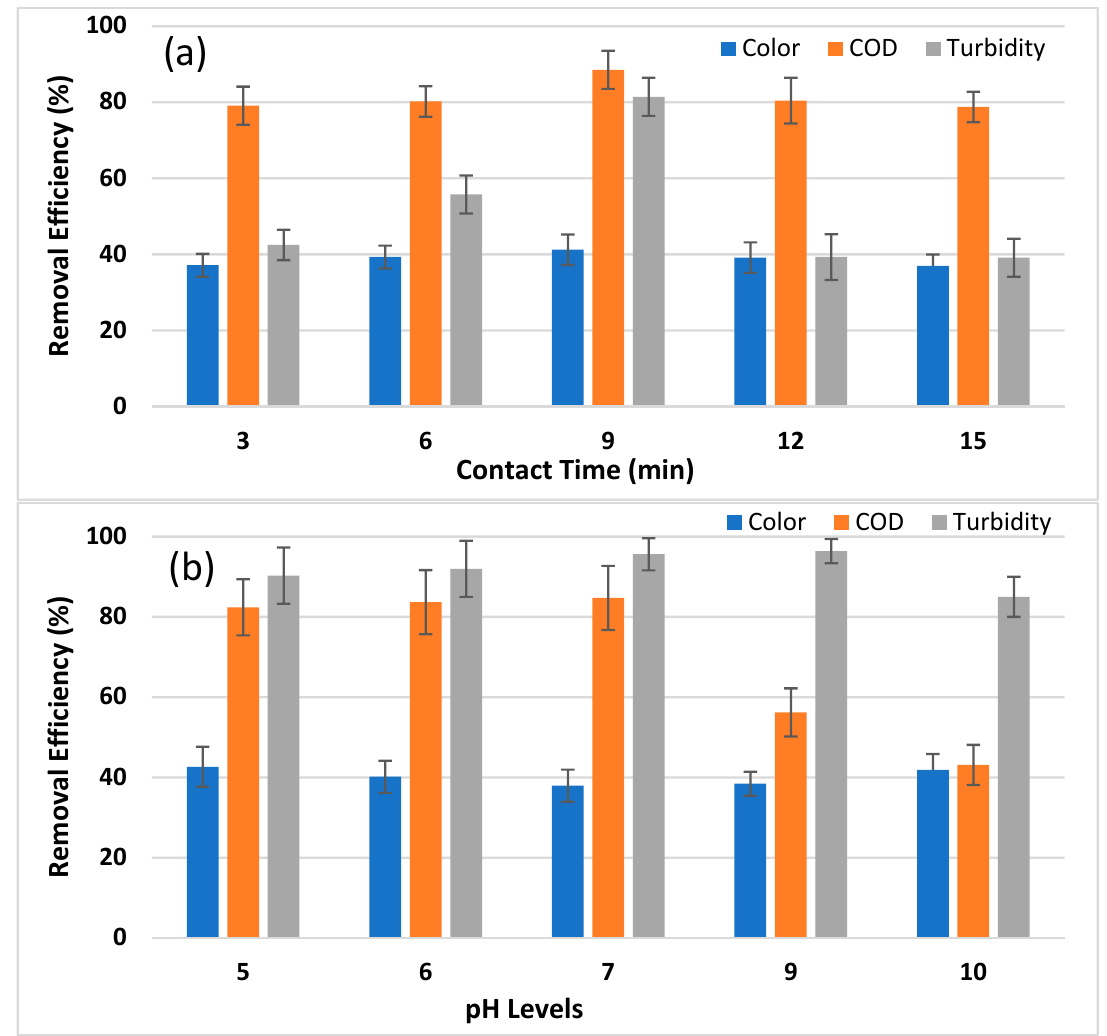
Figure 3. ( a ) Ozone treatment of raw wastewater and removal efficiencies (%) for color, COD and turbidity at varying contact times of 3, 6, 9, 12 and 15 min. ( b ) Ozone treatment of raw wastewater and removal efficiencies (%) for color, COD and turbidity at varying pH values (5, 6, 7, 9 and 10). Means values are presented in graphs with standard deviation.